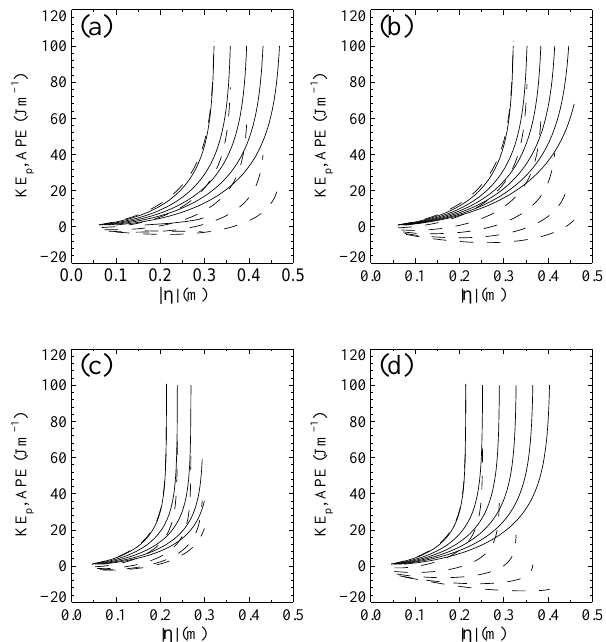
Fig. 1. ¯ E kp (dashed) and ¯ E a as a function of wave amplitude using hyperbolic tangent stratifications with 1ρ = 0 . 04, d pyc = 0 . 05m and hyperbolic tangent shear layers with d s = 0 . 03m. (a) Coincident pycnocline and shear layer near the surface with (z s ,z pyc ) = ( − 0 . 2 , − 0 . 2 ) m. (b) Shear layer below the pycno- cline with (z s ,z pyc ) = ( − 0 . 3 , − 0 . 2 ) m. (c) Shear layer above the pycnocline with (z s ,z pyc ) = ( − 0 . 2 , − 0 . 3 ) m. (d) Coincident py- cnocline and shear layer near the mid-depth with (z s ,z pyc ) = ( − 0 . 3 , − 0 . 3 ) m. In each plot the sets of curves are for different values of U m starting at U m = 0 (left most curve) and decreasing by increments of − 0 . 05ms − 1 . Total water depth is H =